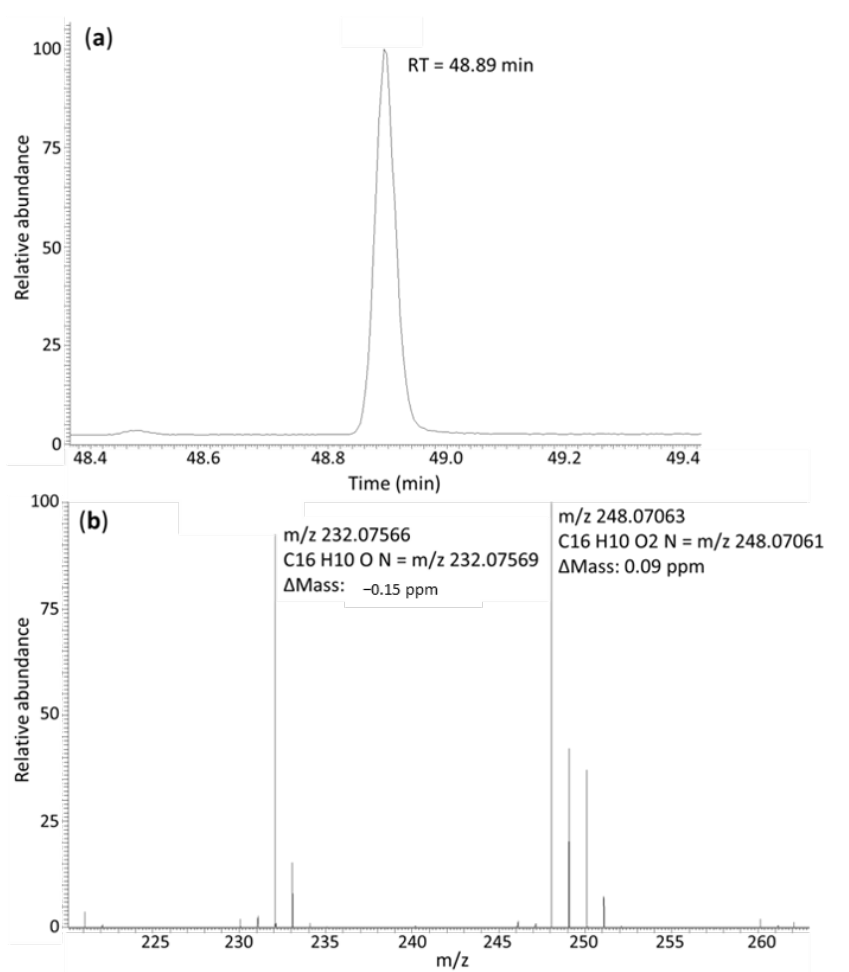
Figure 1. Acquired features for Octoctylene: ( a ) Chromatographic peak; ( b ) HRMS spectrum with the exact masses of selected fragment ions.